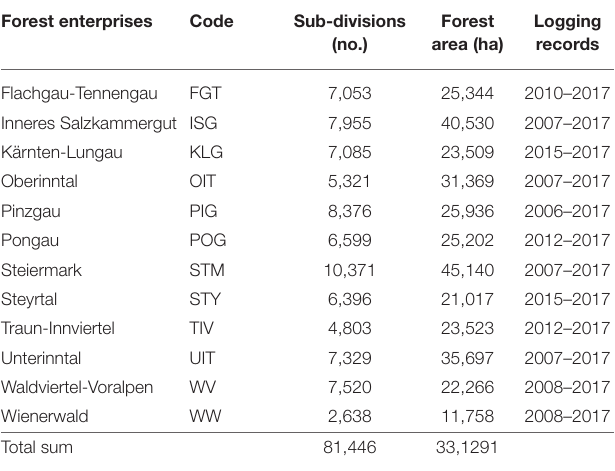
TABLE 2 | German names and codes of ÖBf forest enterprises, number of sub-divisions (forest stands), and corresponding forest area examined, and period for which logging records were